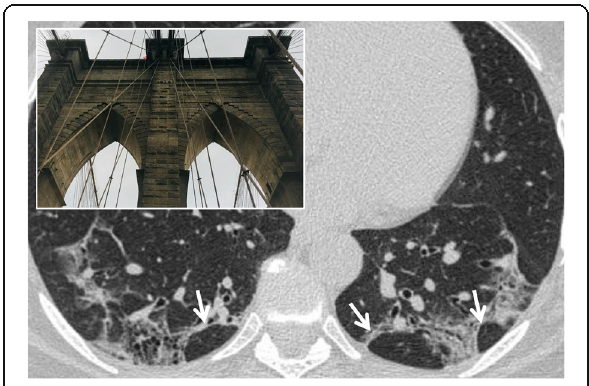
Fig. 3 Arcade-like sign. Perilobular fibrosis in a patient with COP disease, which appears as curved or arched consolidation bands, with shaded margins, distributed around the structures surrounding the secondary pulmonary lobules (white arrows). This pattern resembles an arcade appearance (as reproduced in the embedded picture)